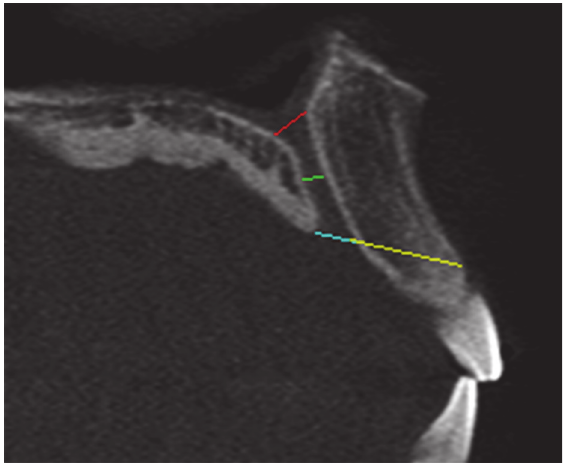
doi:10.1371/journal.pone.0117251.g001